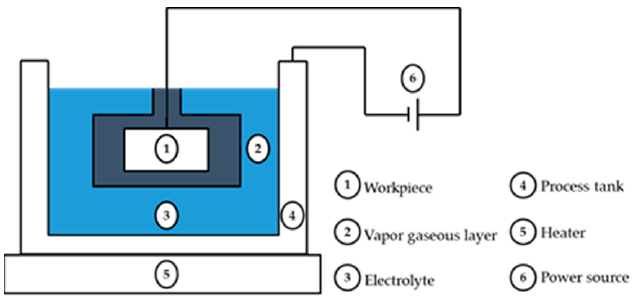
Figure 2. Schematic of plasma electrolytic polishing.